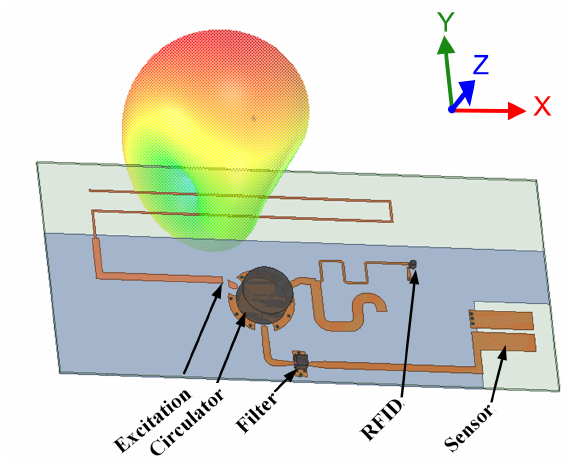
Figure 9. Block diagram of a chip-based multi-port wireless sensor.